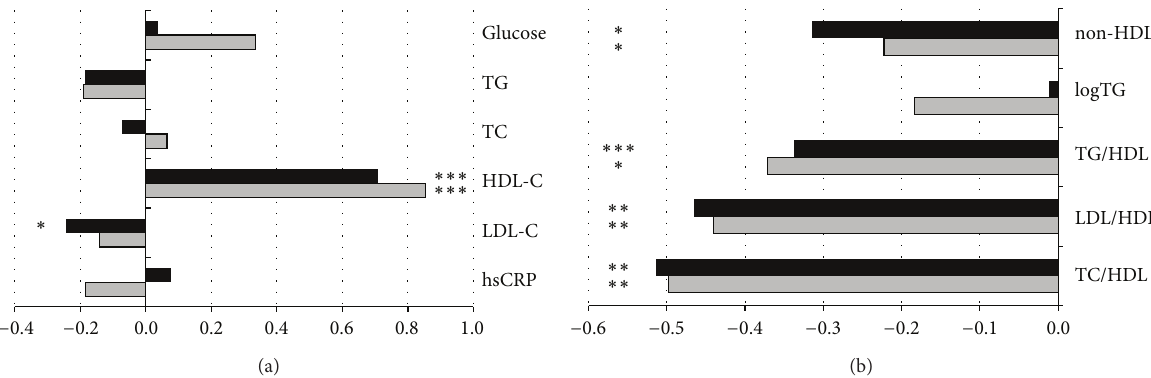
Figure 3: (a-b) Rate of changes of blood biochemical indices after Active Leisure Time Programme (black bars) and Prevent Falls in the Elderly Programme (grey bars), compared to baseline. Note: values are mean normalised outcomes. TG: triglycerides; TC: total cholesterol; HDL-C: cholesterol high density lipoprotein; LDL-C: cholesterol low density lipoprotein; hsCRP: high sensitive C-reactive protein. Levels of statistical significance: ∗ 𝑃 < 0.05 , ∗∗ 𝑃 < 0.01 , and ∗∗∗ 𝑃 < 0.001 .